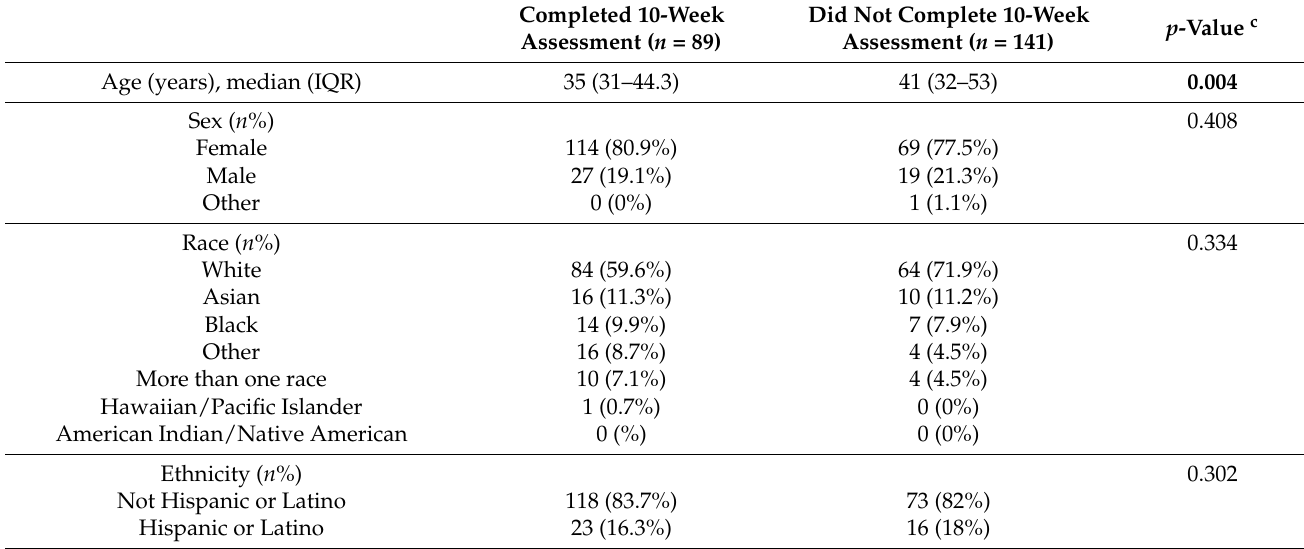
Table 2. Comparison of baseline characteristics between participants who completed the 10-week follow-up assessment ( n = 89) and those who did not complete the 10-week follow-up assessment ( n =